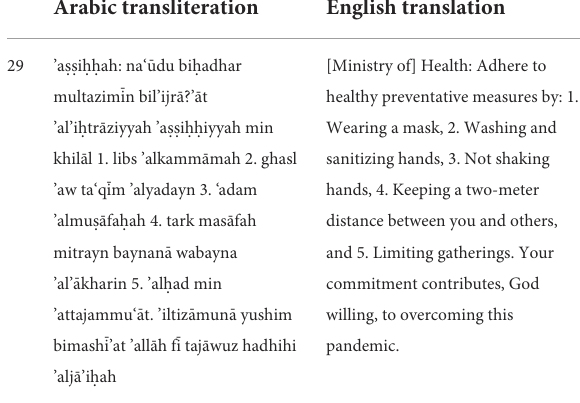
TABLE 11 Examples of the use of the commitment–social proof–authority pattern.